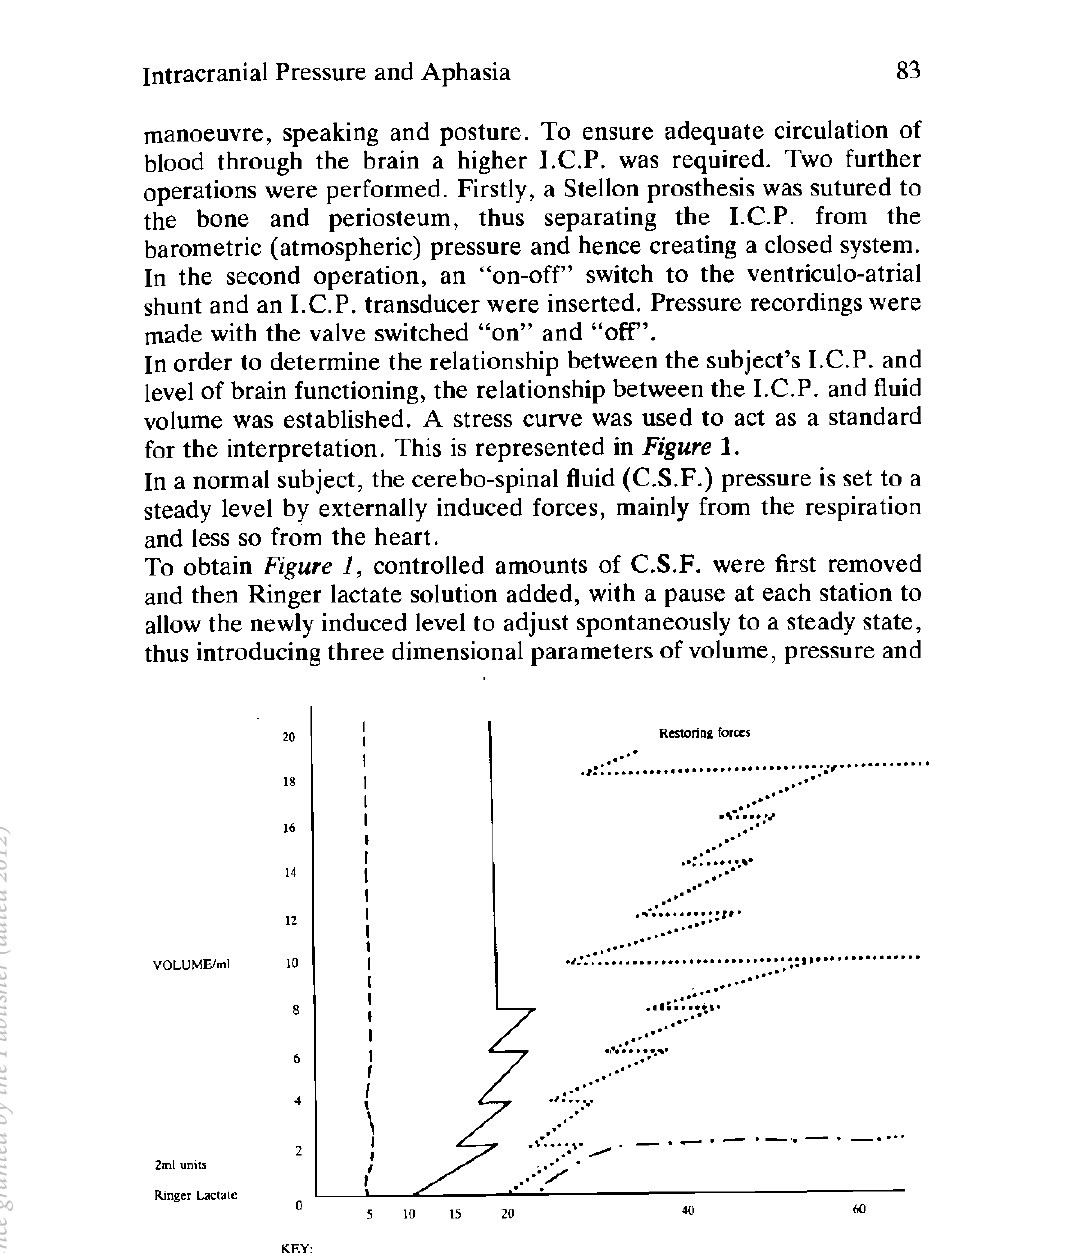
Figure 1. A diagramatic representation of the subject's I.C.P. functioning with an increase in cerebro-spinal fluid volume. Die Suid-Afrikaanse Tydskrif vir Kommunikasieafwykings, Vol. 28,